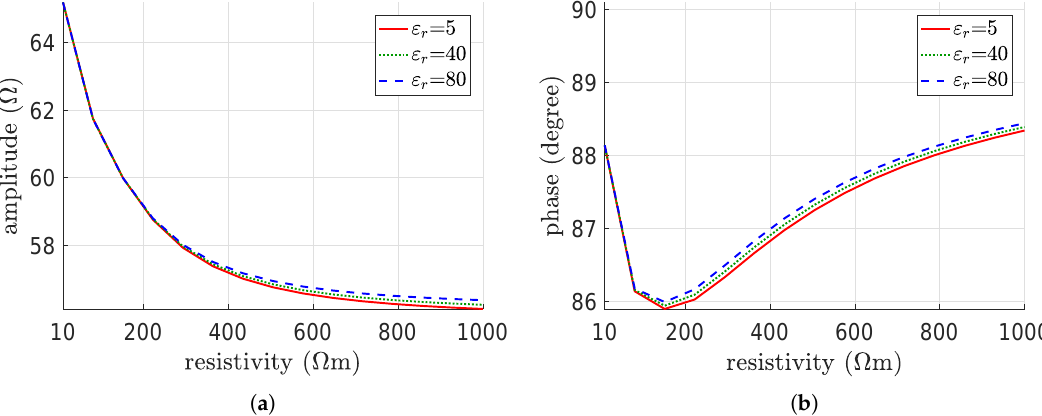
Figure 17. Equivalent impedance of the embedded coil ( Mod2 ) at 50 kHz for a concrete resistivity from 10 Ω m to 1000 Ω m, parametrized for ε r equal to 5, 40, and 80. Amplitude ( a ); phase ( b ).